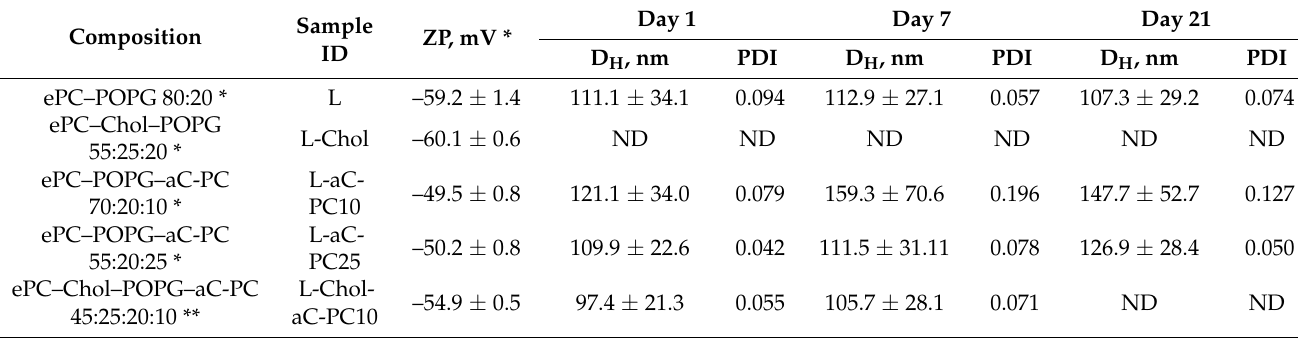
Table 1. Studied liposome compositions and their